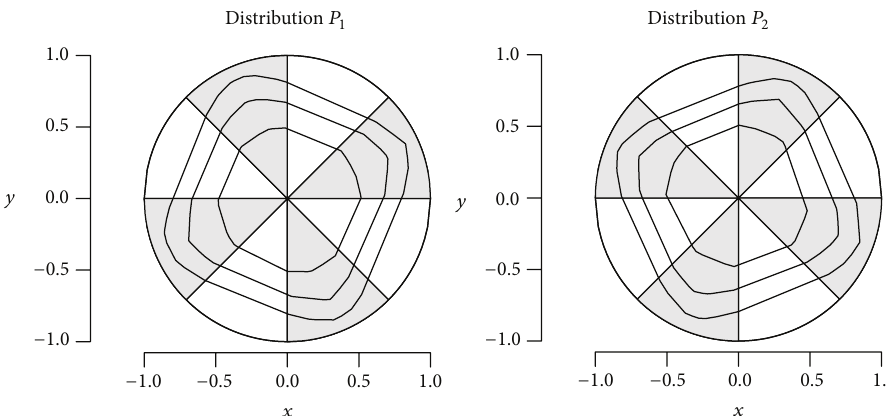
Figure 1: Supports of two bivariate uniform distributions (represented by grey areas). Estimated (solid curves) are halfspace depth central regions of 25, 50, and 75 percent of deepest points.